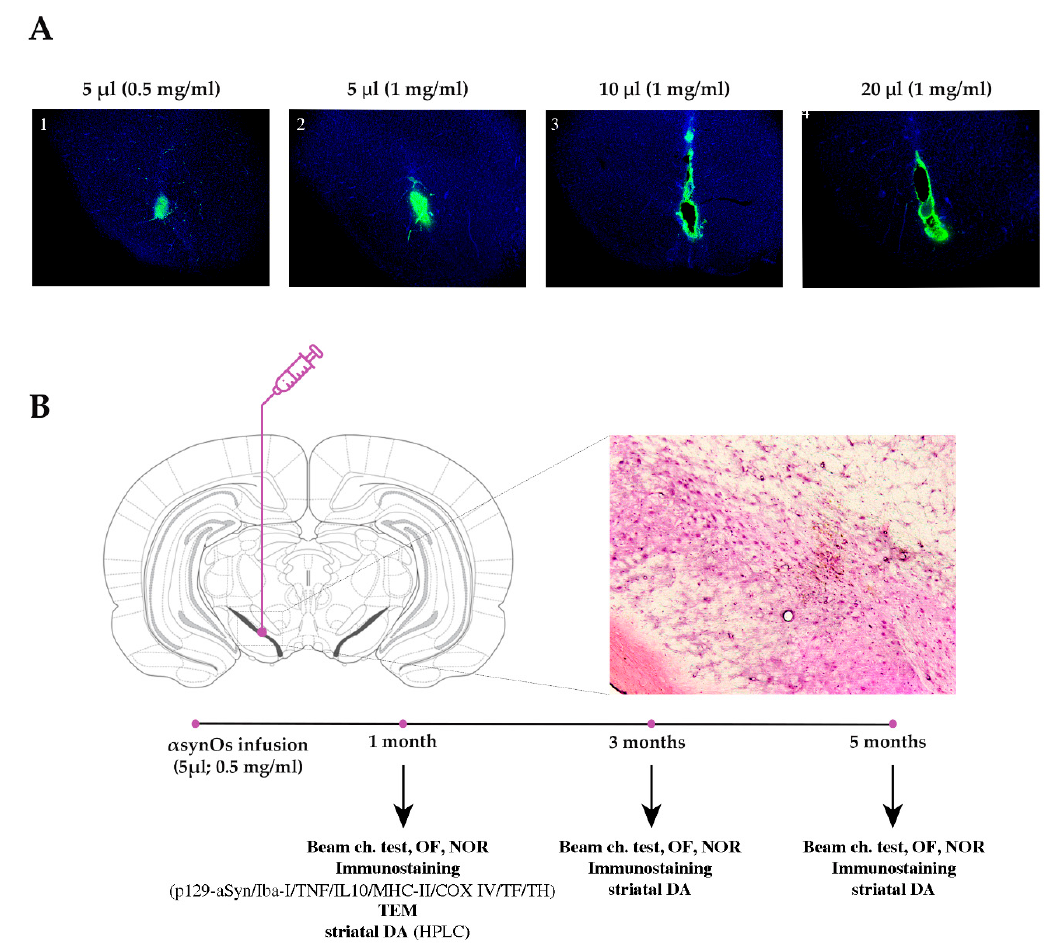
Figure 2. Representative pictures of the substantia nigra (SN) from rats infused with fluorescent H- α synOs at increasing concentration and volume ( A ). Experimental design showing the site for H- α SynOs infusion in vivo, behavioral tests, and biochemical assays at progressive time-points ( B ). Insert in B shows hematoxylin and eosin (H&E) staining in a SN section adjacent to A-1. Beam